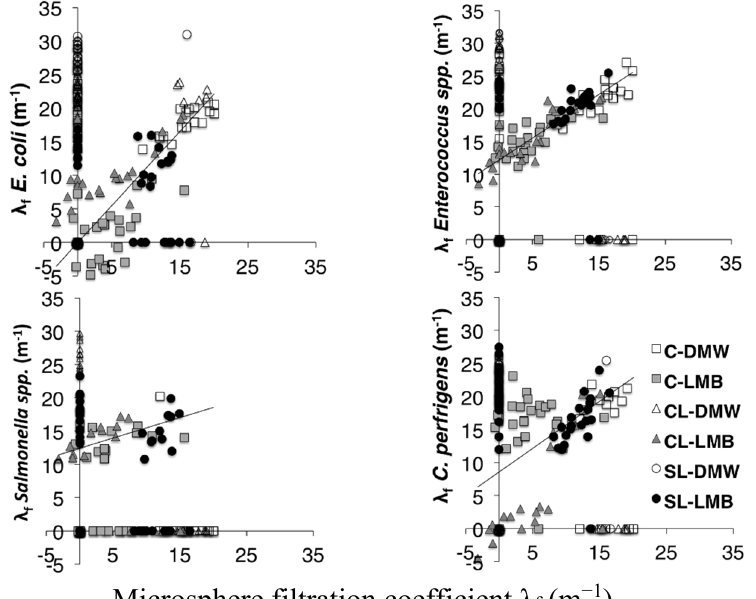
Figure 3. Relationship between the filtration coefficients of microspheres and bacterial indicators (Event 1). For graphical simplicity non-detects ( λ f = ∞ ) were assigned a filtration coefficient of 0. Linear regressions were fitted to all data points for which both λ f ≠ ∞